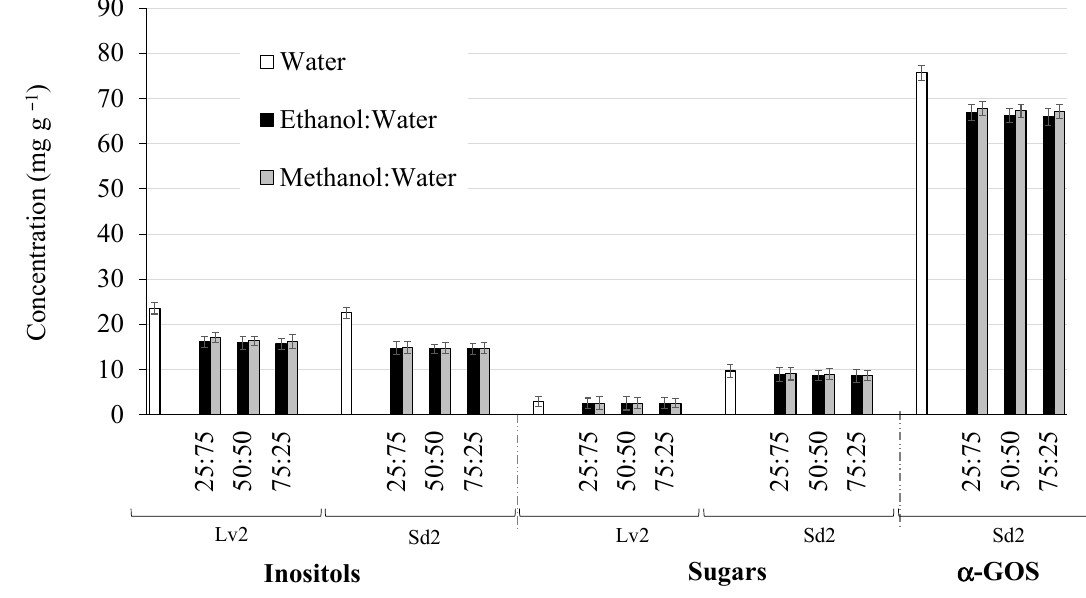
Figure 2. Inositol, sugar and α -GOS yields of Lv2 and Sd2 SLE extracts obtained using different extraction solvents. Lv2, leaves; Sd2, seeds; α -GOS, α -galactooligosaccharides